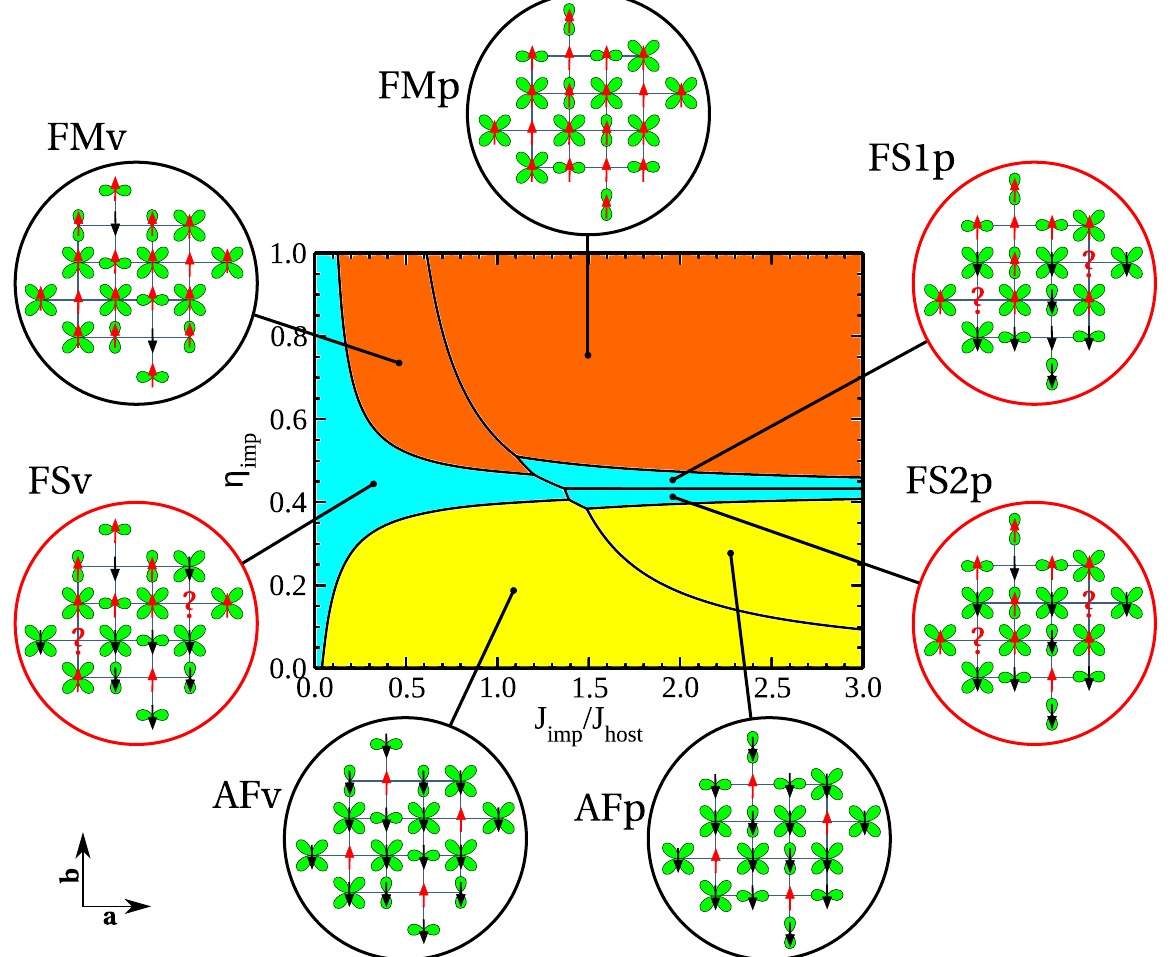
FIG. 10. Ground-state diagram for an x ¼ 1 = 5 periodic concentration of 3 d impurities (sites where orbitals are absent) with schematic views of the ground-state configurations obtained for the unit cell of 20 sites. The spin and orbital orders are shown by arrows and orbitals occupied by doublons; magnetic phases (AF, FS, and FM) are highlighted by different colors. The question marks in the FS states (red circles) indicate frustrated impurity spins within the classical